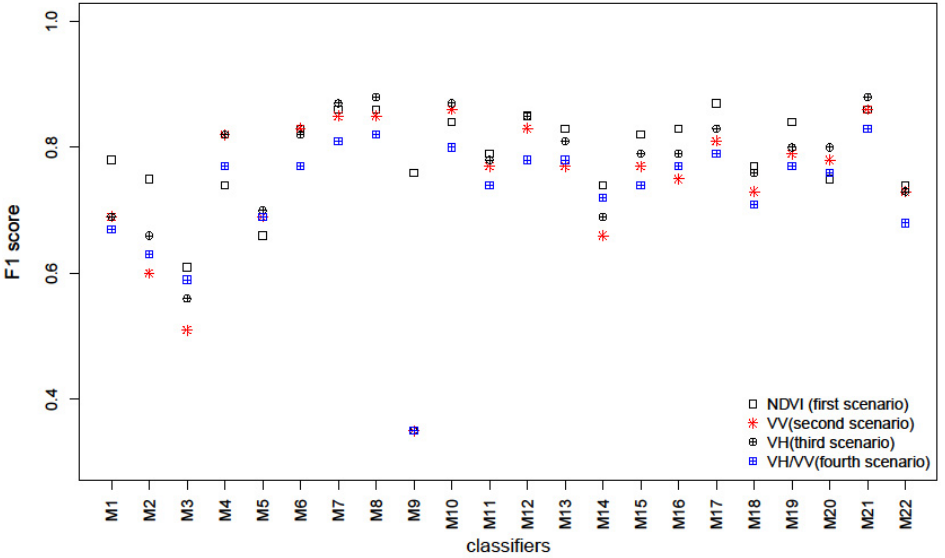
Figure 8. F1 score statistics of classification methods of the first approach.